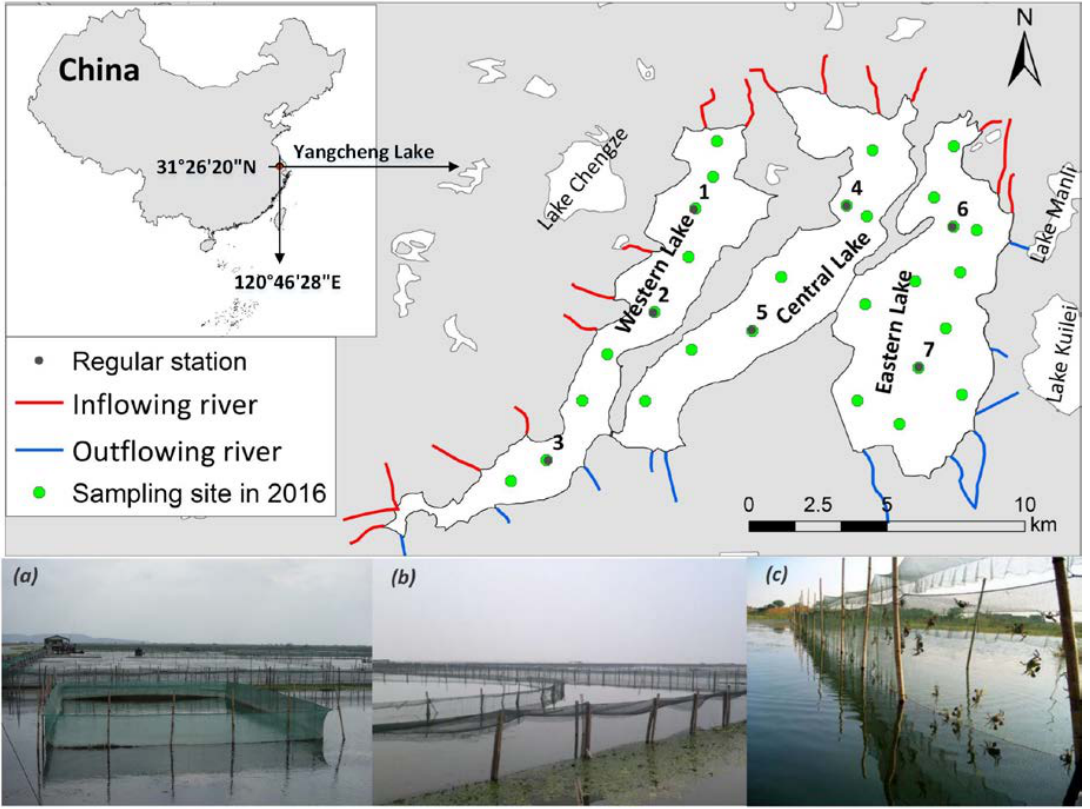
Figure 1. Study area (i.e., Lake Yangcheng, including the Western, Central and Eastern Lakes) and sampling stations/sites location map and site photos of pen aquaculture ( a – c ).